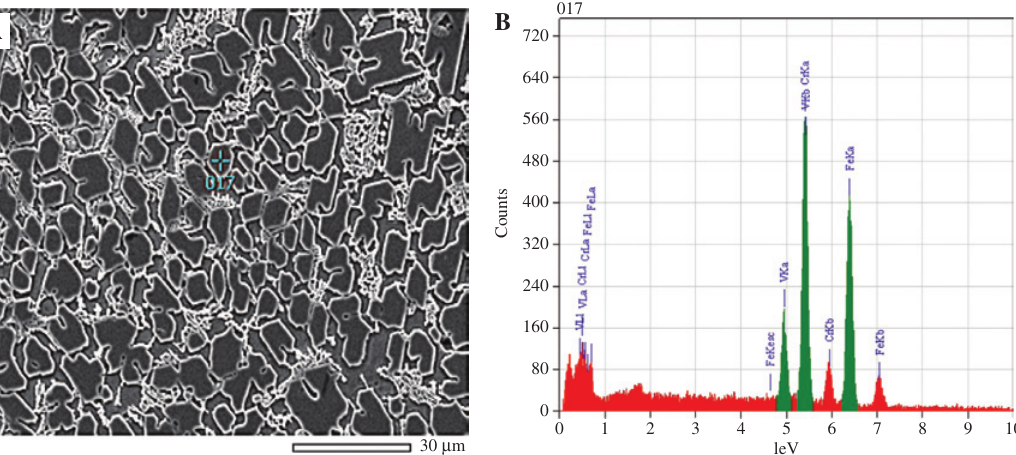
Figure 5 Microstructure and chemical composition (EDS) analysis of FeCrBVC alloy cladding: (A) microstructure of FeCrBVC alloy cladding, (B) EDS analysis of point